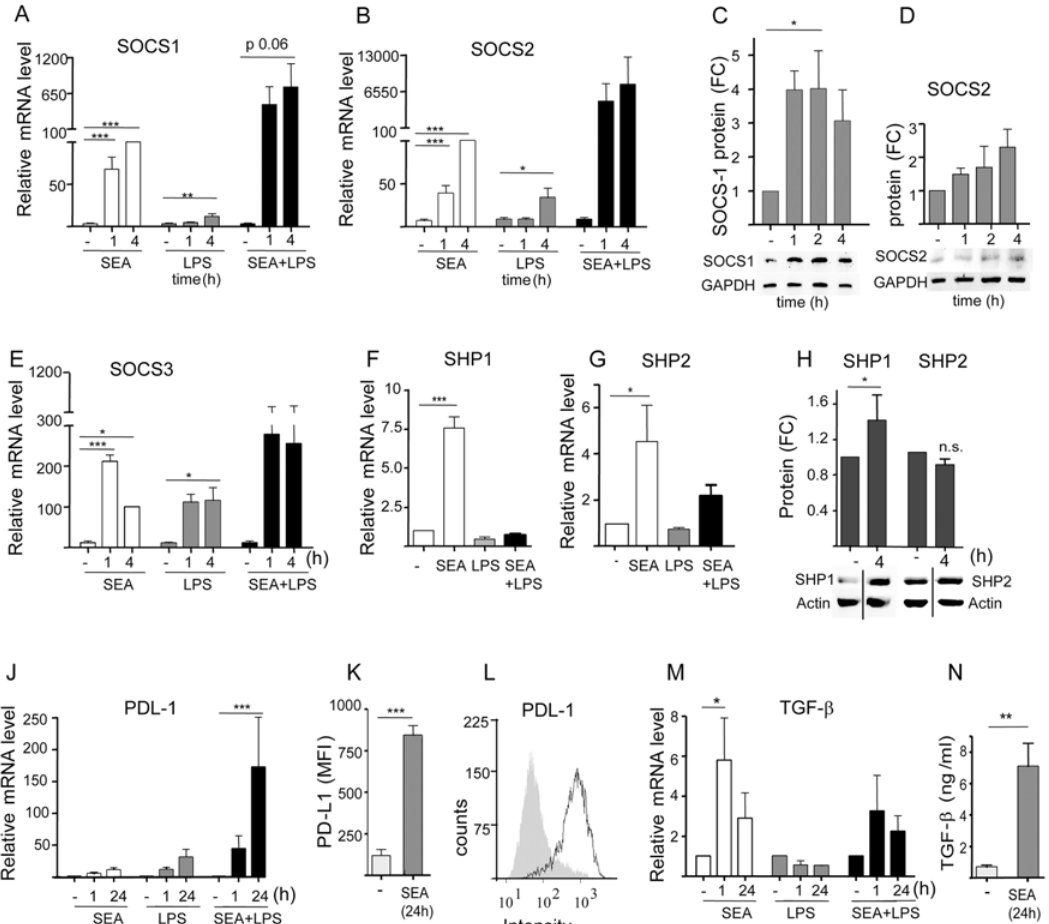
Fig 3. S . mansoni SEA induces mRNA and protein expression levels of Suppressor of Cytokine Signaling 1 (SOCS1), SH2-containing protein tyrosine phosphatase 1 (SHP1), Programmed Death Ligand 1 (PD-L1) and transforming growth factor β (TGF- β ), in human dendritic cells (DCs). DCs were cultured with SEA (40 μ g/ml) and/or LPS (10 ng/ml) for the indicated time periods. mRNA levels were detected using quantitative real time PCR with GAPDH as a reference gene, whereas protein levels were determined by SDS-PAGE and western blotting, using specific antibodies and reference gene antibodies on the same blots. Quantification of protein was performed by density scanning. In A , B , and E , respectively, the mRNA levels of SEA-induced SOCS1, SOCS2, and SOCS3 are shown, whereas the protein levels of SOCS1 and SOCS2 are shown in C and D , respectively. In F and G, respectively, the mRNA levels of SEA-induced SHP1 and SHP2 are shown, and their protein levels are shown in H . The mRNA levels of PDL-1 and TGF- β are shown in J and M , respectively. Protein levels of PD-L1 were determined by flow cytometry ( K) and TGF- β 1 protein levels were determined by ELISA ( N ). L shows a typical example of a FACS plot from one of the experiments shown in K . Results are shown as mean fold difference from unstimulated DCs, plus or minus SEM. Results are derived from experiments performed in duplicate using DCs derived from 7 (A), 4 (B, D, E, G, H, J, N) or 3 (C, F, M, K) different donors. Significance is indicated versus unstimulated DCs as * p < 0.05, ** p < 0.01 and *** p <